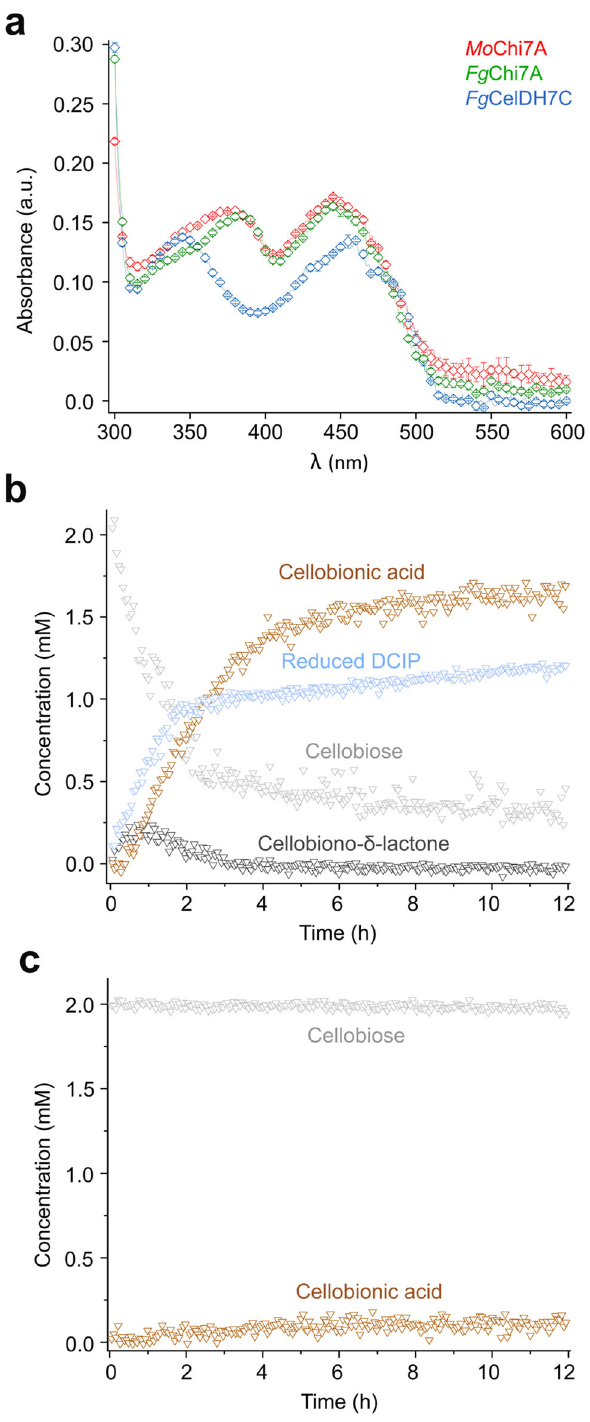
Fig. 2 Spectral properties and time-course NMR analysis of the AA7 cellooligosaccharide dehydrogenase Fg CelDH7C. a Spectral comparison of the fl avin absorbance of Fg CelDH7C and the oxidases Fg Chi7B as well as Mo Chi7A, all at 20 µ M. The data are means ± standard deviations ( n = 3 independent experiments). b and c Show the time resolved in situ 1 H NMR analyses of the oxidation of cellobiose by Fg CelDH7C in the presence ( b ) or absence ( c ) of 1.3 mM 2,6-dichlorophenolindophenol (DCIP) as an electron acceptor, respectively. The presented spectra in panels b and c are from a single experiment ( n = 1). Source data are provided as a Source Data fi